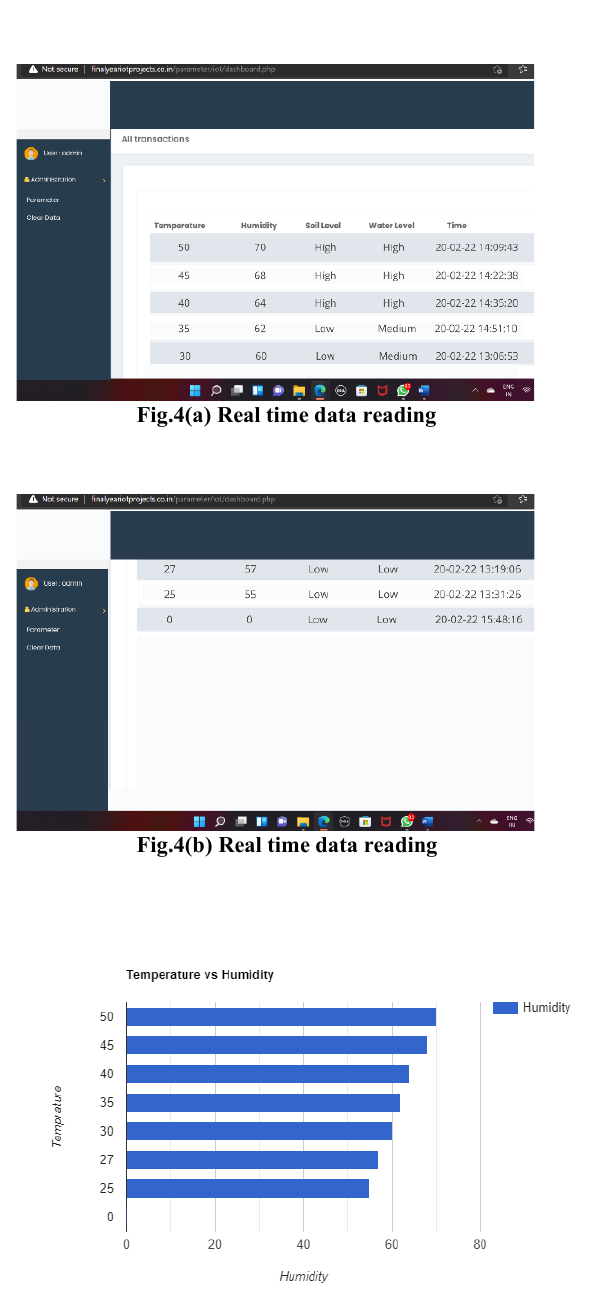
Fig.4(c)Graph of temprature vs humidity